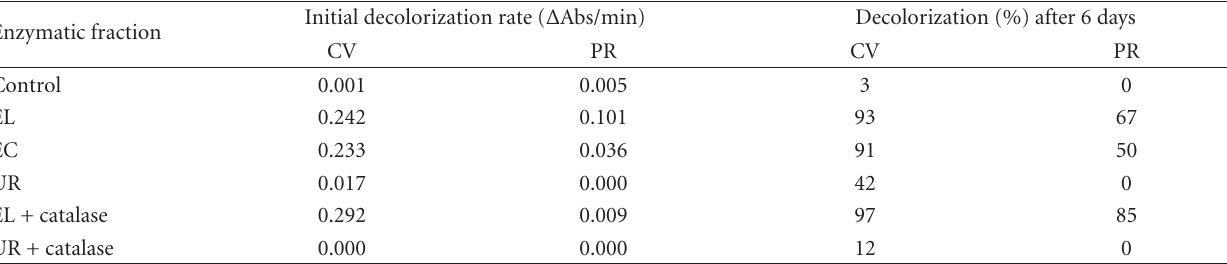
Figure 3: Decolorization of PR by three enzyme fractions (EL: extracellular liquid; EC: enzymatic crude; UR: ultrafiltration residue). Time of reaction: 0h (black), 0.5h (red), 2h (light green), 4.5 h (yellow), 1d (blue), 3 d (violet), 6d (cyan). Table 1: Decolorization of crystal violet (CV) and phenol red (PR) with di ff erent enzymatic fractions and addition of catalase in reaction